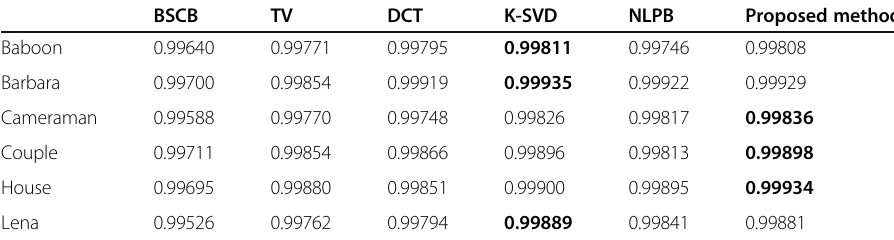
Table 6 The SSIM of each method for removing scratches BSCB TV DCT K-SVD NLPB Proposed method